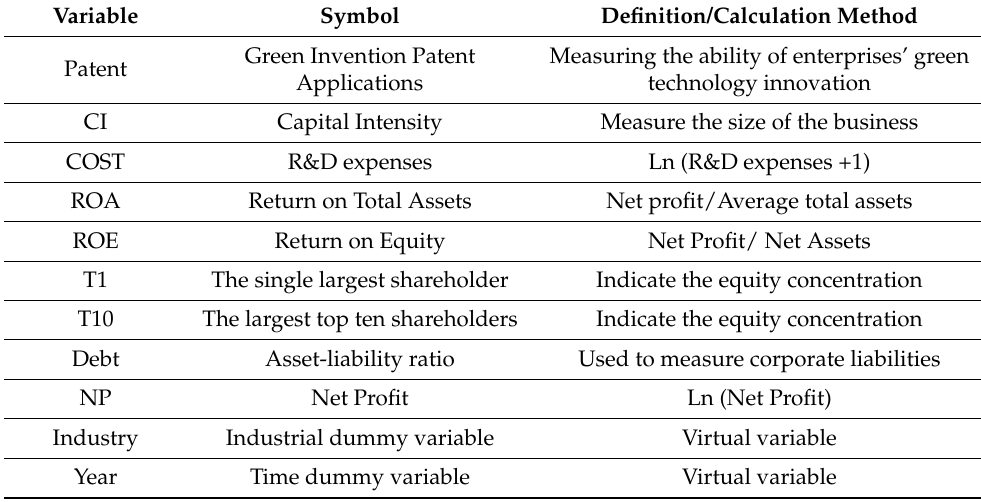
Table 1. Interpretation of